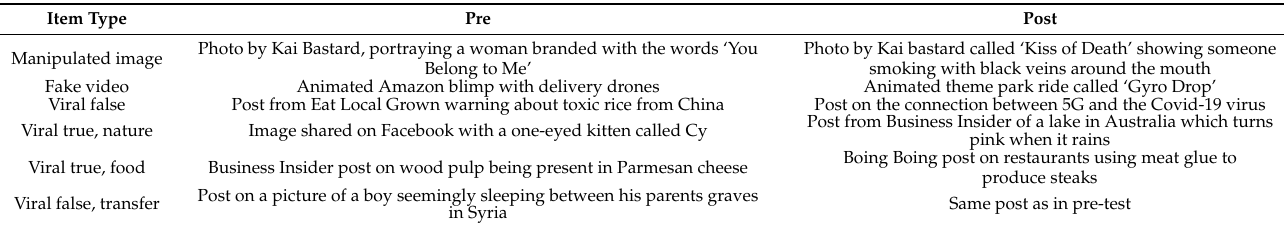
Table 1. Items used pre- and